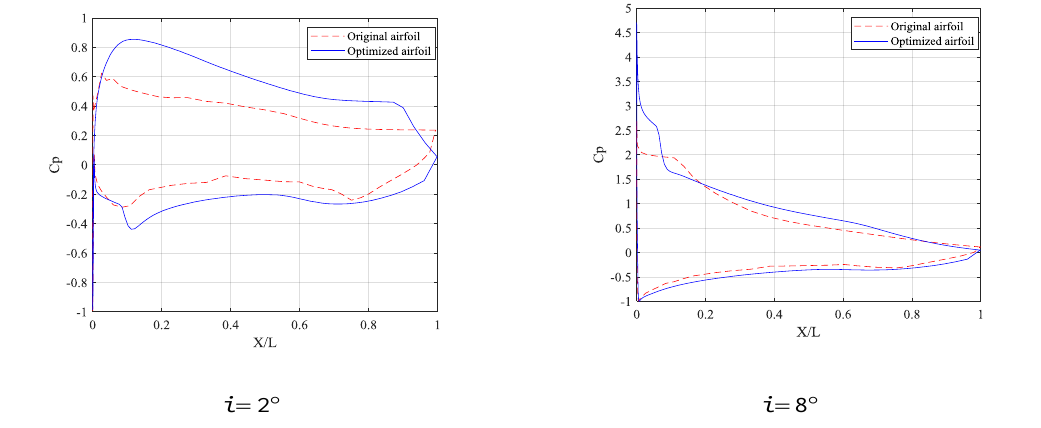
Figure 15. Geometric comparisons of the optimized and original cascades.